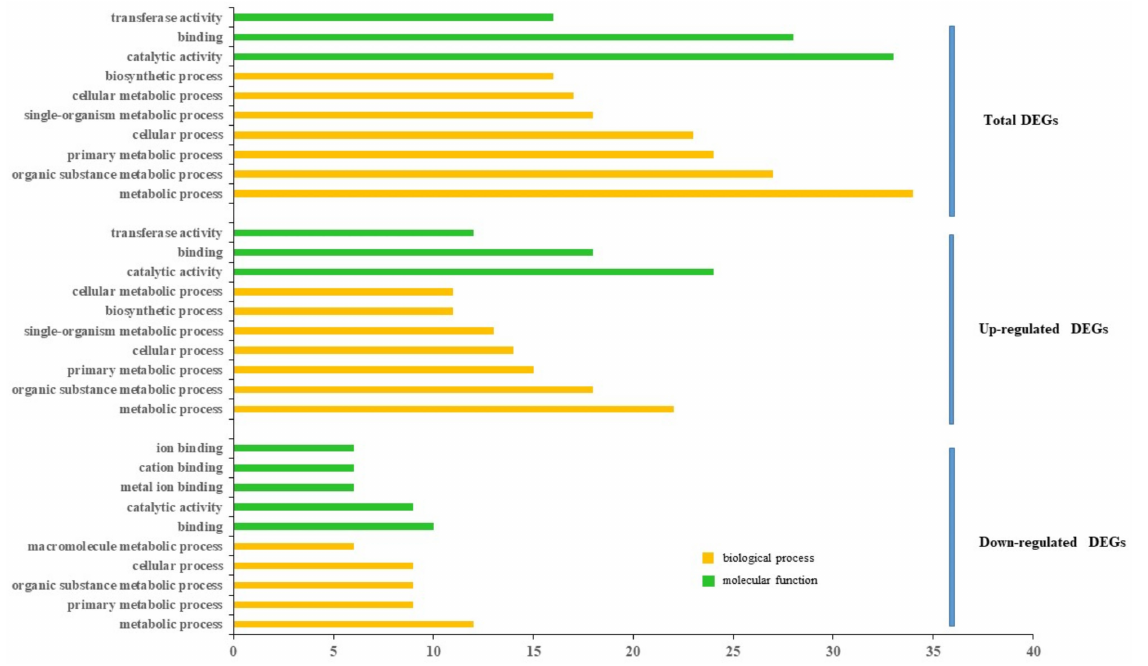
Figure 3. Identification and GO functional enrichment analysis of